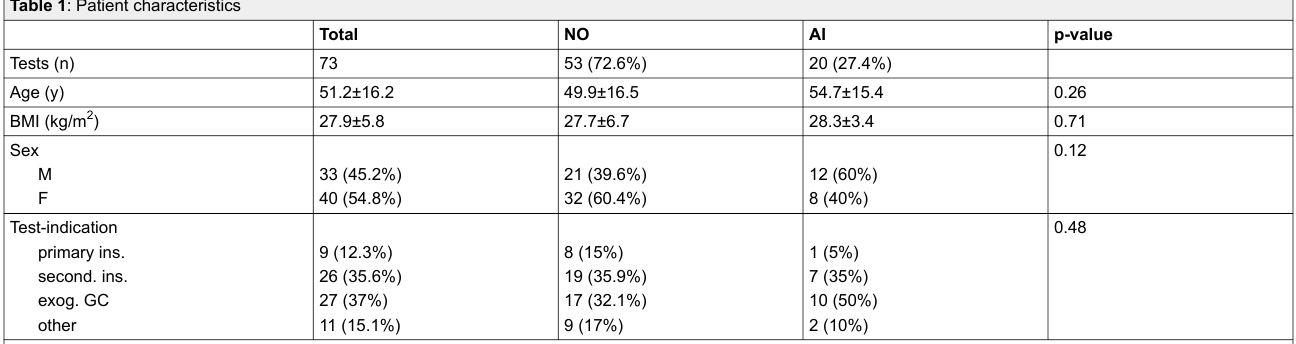
Table 1 : Patient